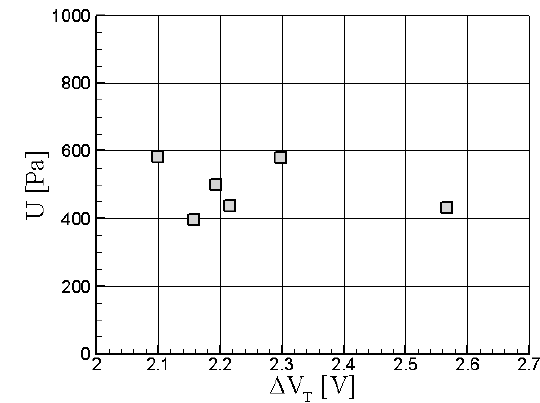
Figure 5. Extended uncertainty for the different probe temperature.